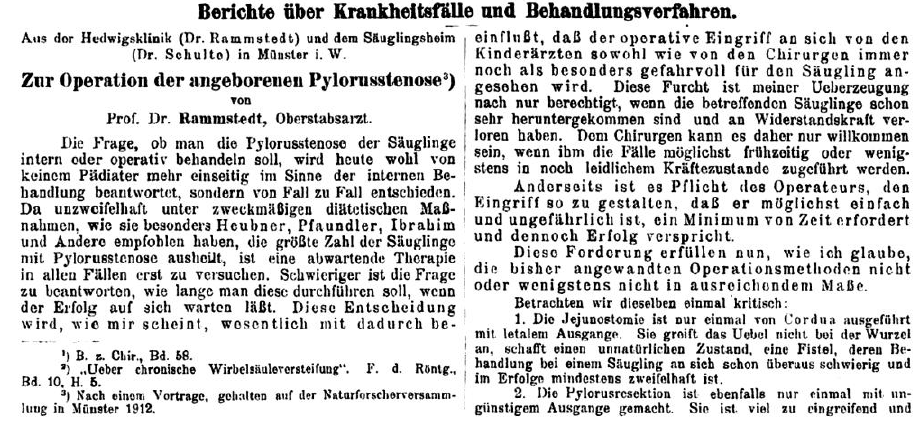
Figure 2: Title page of the historic article.